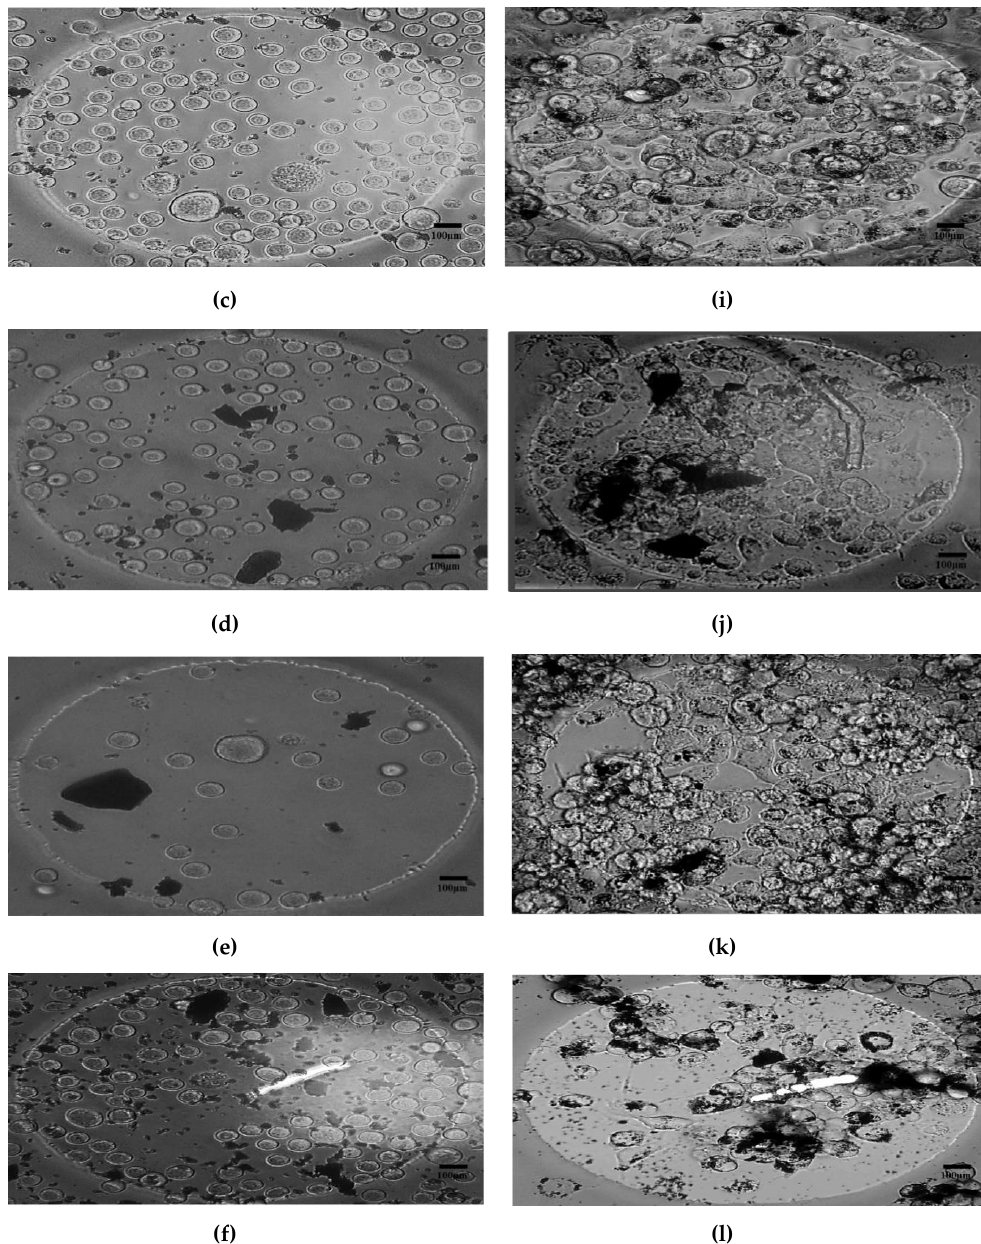
Figure 8. Photomicrograph of N2a cells exposed to the different concentrations of SPIONs on the surface of a 250μm diameter electrode on a clear polycarbonate substrate. Images in a , b , c , d , e , and f were taken at T1 while g , h , i , j , k , l at T8. a, g = untreated N2a; b, h = treated with 25 µg/mL; c, i = 50 µg/mL; d, j = 100 µg/mL; e, k = 100 µg/mL; f, l = 100 µg/mL SPIONs concentrations. Scale bar 100 µm.